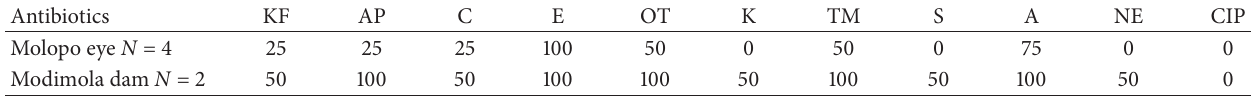
Table 8: Percentage of Aeromonas spp. resistant to various antibiotics.